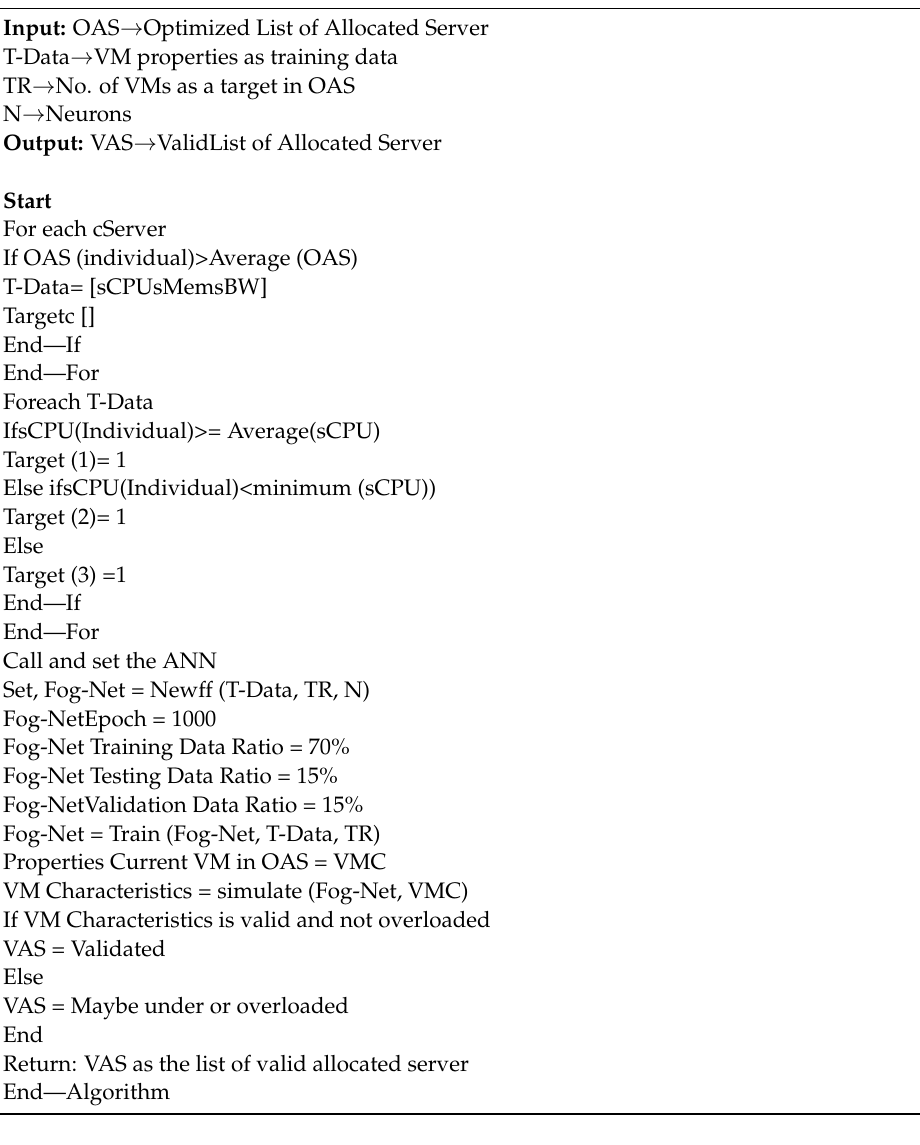
Algorithm 3. Algorithm of ANN for Overflow Handling (Artificial Neural Network) with